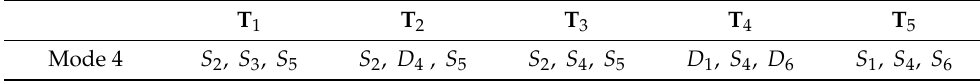
Table 5. Switching states in modes